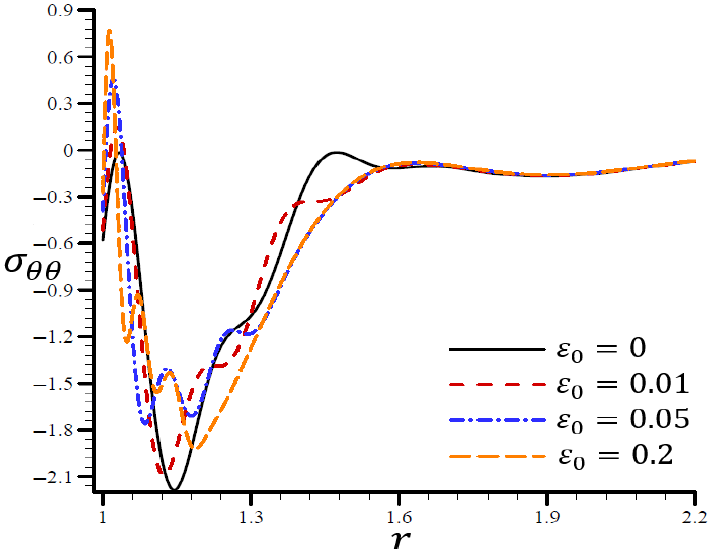
Figure 21. The influence of 𝜀 0 on circumferential stress 𝜎 𝜃𝜃 through the radial direction of the spherical hole using the RTPL model.